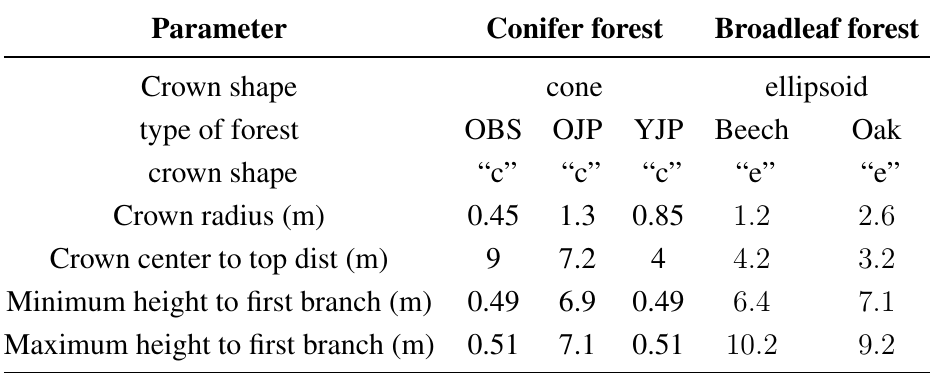
Table 3. FLIGHT input parameters: Crown shapes, where “c” represents cone shape and “e” represents ellipsoid